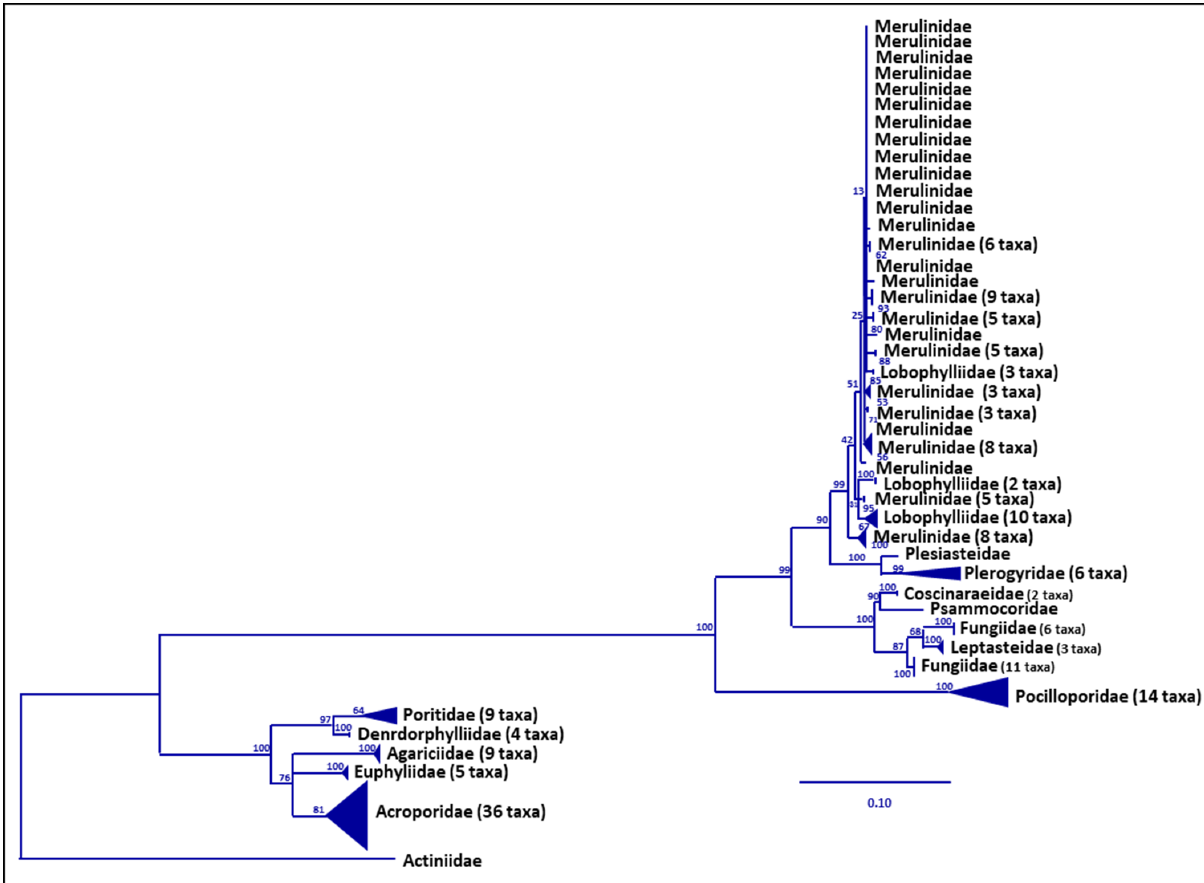
Figure 2. Underwater and close-up documentation of: ( A , B ) Cyphastrea magna (Benzoni and Arrigoni, 2017) (sample SIRS-080), ( C , D ) Psammocora profundacella (Gardiner, 1898) (sample SIRS-184) and ( E ) Sclerophyllia margariticola (Klunzinger, 1879) (sample SIRS-083). Black bars—1.0 cm ( A , C , E ), white bars—1.0 mm ( B , D ).